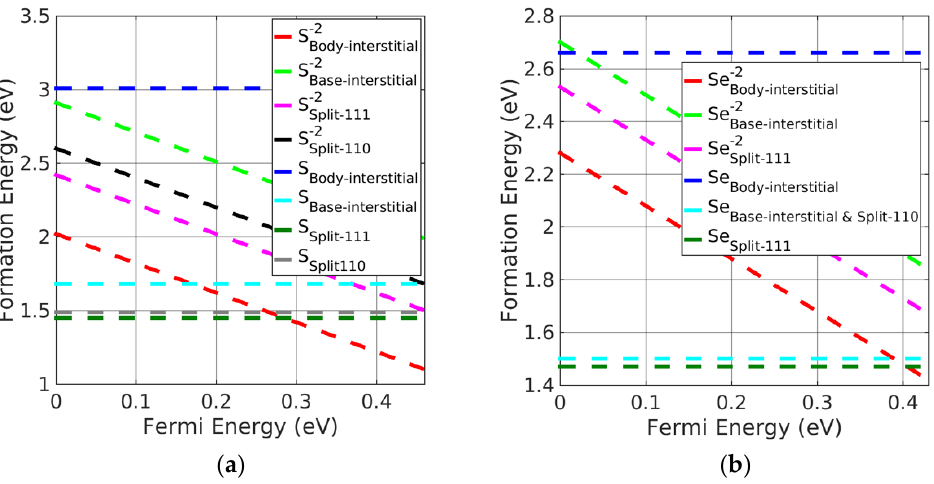
Figure 4. Formation energy of charged interstitial defects in ( a ) PbS at S − rich and ( b ) PbSe at Se − rich conditions.